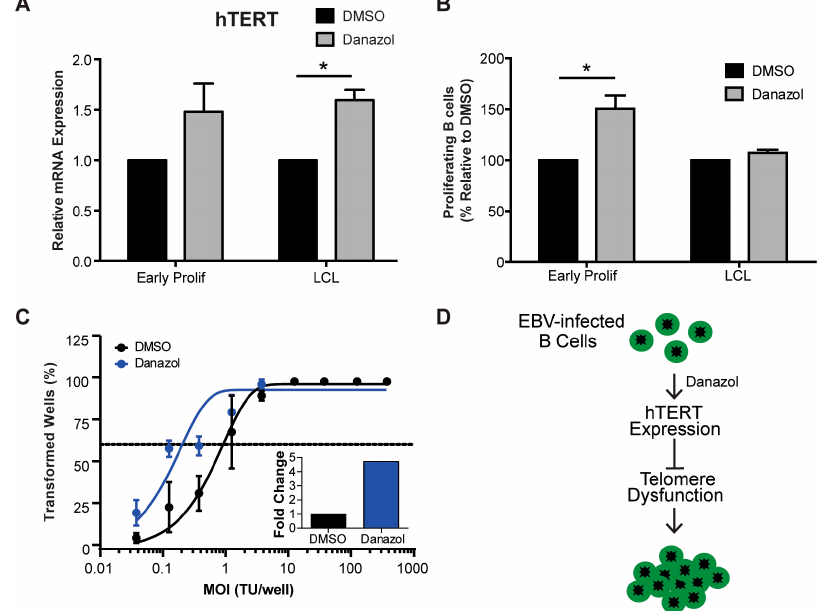
Figure 3. Danazol treatment enhances EBV-mediated B-cell transformation. ( A ) The expression level of hTERT mRNA was measured from sorted early proliferating CD19+ infected B cells on day 7 and LCLs. Relative mRNA abundance was normalized to SETDB1. Data are represented as the fold change relative to DMSO treatment. Error bars represent S.E.M. of three independent donors. * p < 0.05 as determined by a Student’s t -test. ( B ) Percentage of proliferating CD19+ B cells was determined for early proliferating infected B cells and LCLs that were treated with DMSO (black) or with 3 µ M danazol (grey) at the time of infection. The data were analyzed by FACS at day 7 post-infection. Error bars represent S.E.M. of three independent donors. * p < 0.05 as determined by a Student’s t -test. ( C ) Quantification of EBV-infected B cell outgrowth following PBMC infection in the presence of DMSO (black) or 3 µM danazol (blue) at the time of infection. The percentages of wells positive for LCLs at five weeks post-infection are plotted relative to the transforming units (TU) of B95-8 virus per well. Error bars represent S.E.M of three independent donors. Dotted line represents 62.5% positive wells, which indicates outgrowth from the virus amount in the x -axis of a single LCL per well based on a Poisson’s distribution. ( C , inset ) Fold change of the transformation efficiency. ( D ) Schematic of danazol’s mechanism of action during EBV